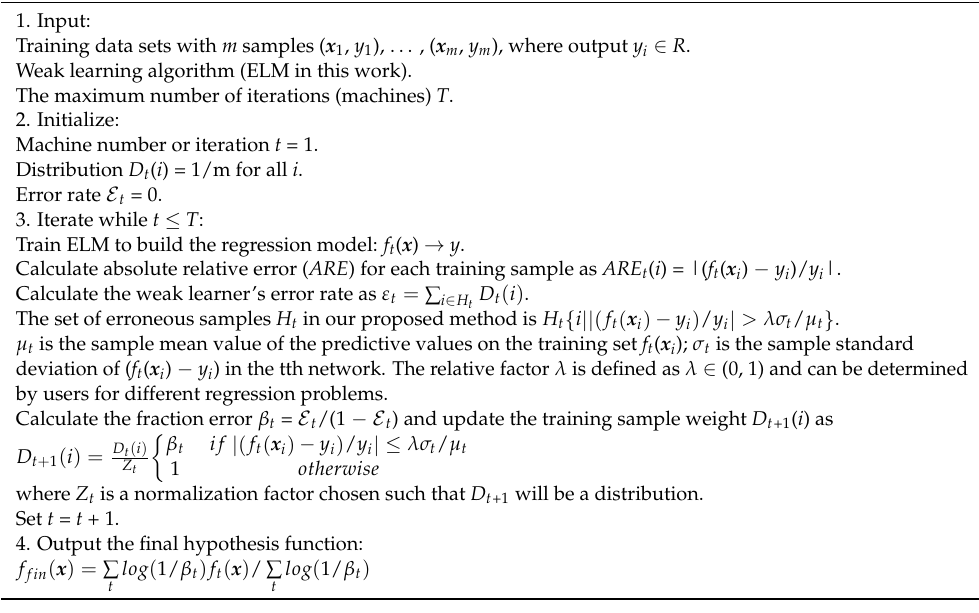
Algorithm 2: Learning Routine of the Modified